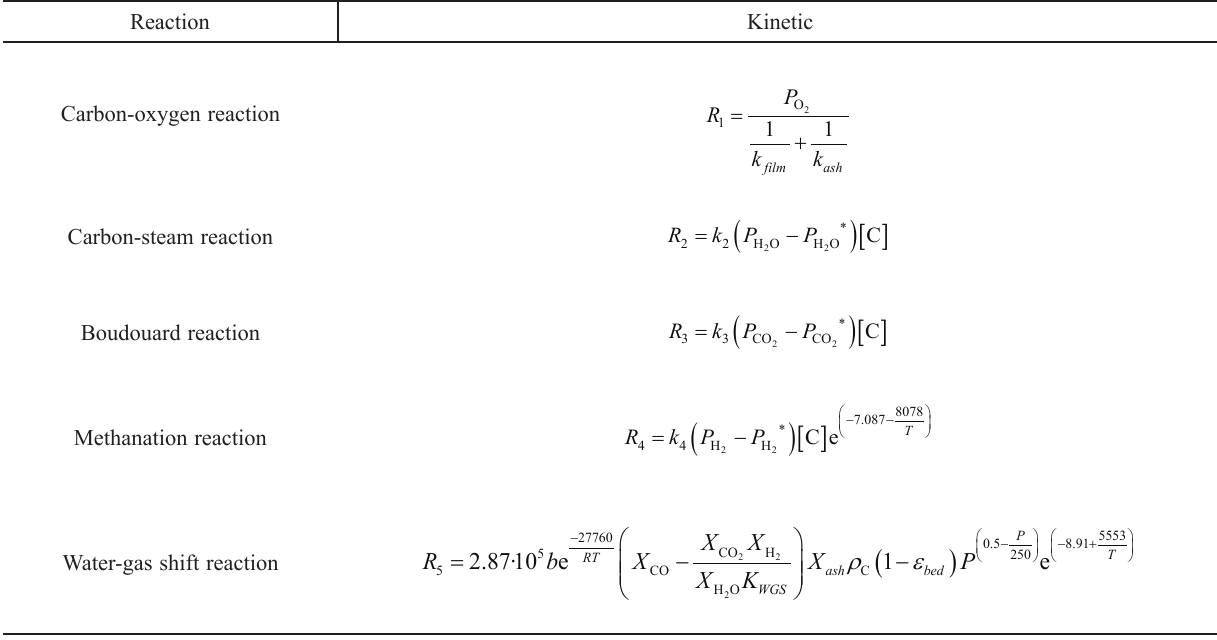
Water-gas shift